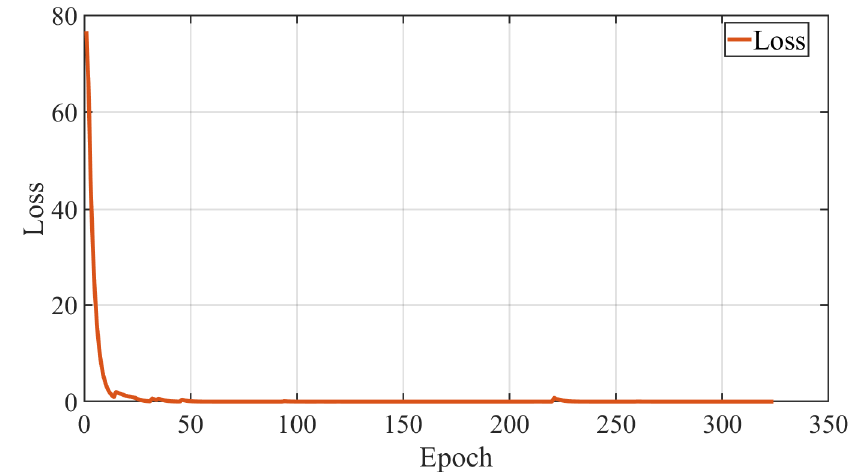
Sensors 2022 , 22 , x FOR PEER REVIEW Figure 12. The loss function change of the proposed recognize model. Figure 12. The loss function change of the proposed recognize model.